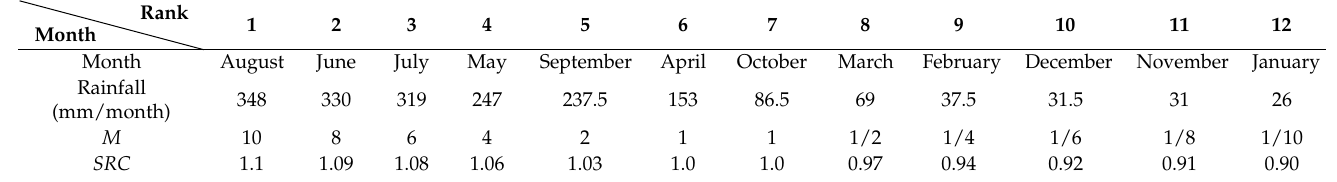
Table 4. Monthly rainfall ranking and corresponding SRC s in